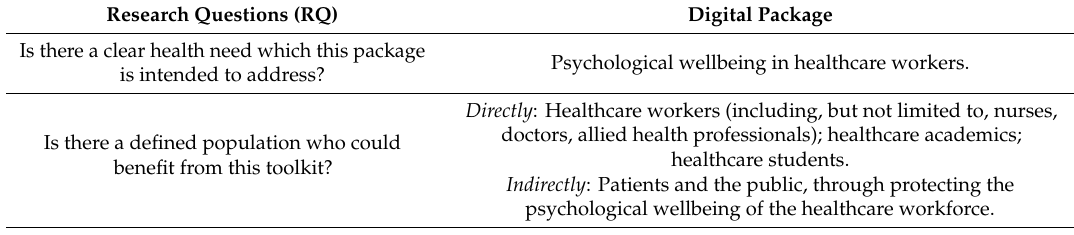
Table 2. Mapping Research Questions (RQ) to Digital Package